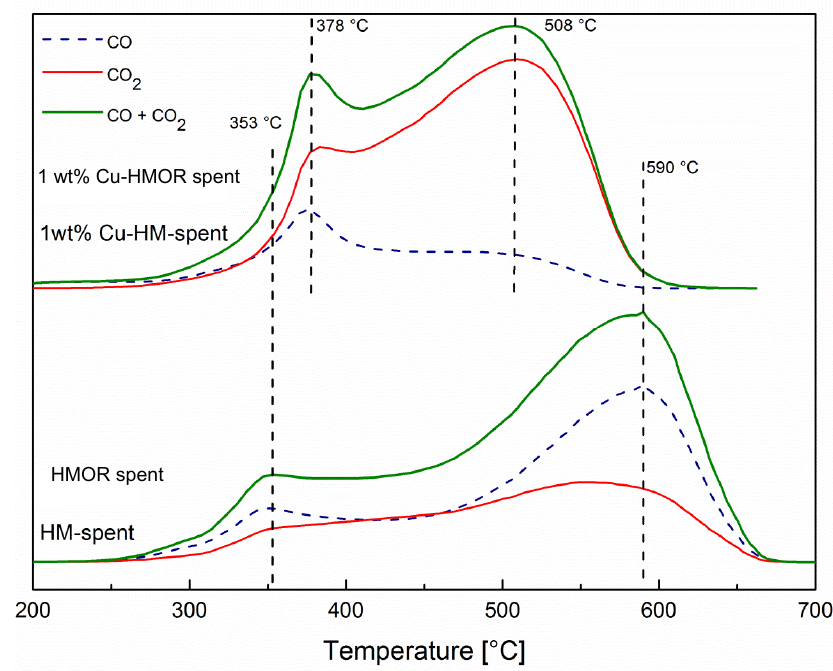
Figure 5. TPO of spent HMOR and 1 wt% Cu-MOR catalysts. The nature of the copper-species in the 1 wt% Cu-MOR catalyst was examined before and after the reaction by XPS (Figure S6) and EPR spectroscopy (Figure S7). The charac- teristic binding energies of Cu at 933.5 and 953.2 eV in XPS resulted from the spin-orbit doublet of the Cu 2p core level transitions. Deconvolution of the Cu transition 2p 3/2 signal resulted in two main contributions located around 933.5 and 935 eV, respectively, which tentatively was assigned to CuO [51] (or to Cu 2+ introduced by cation exchange [52]) and to Cu 2+ -species with a different coordination or environment [53]. The characteristic satellite features of the Cu 2p transitions can further distinguish oxidation states in the catalysts. In the fresh Cu-MOR catalyst, a satellite doublet peak between 940 and 945 eV confirmed the presence of Cu 2+ species whereas a weak satellite between 945 and 950 eV suggested the presence of Cu + -species in the spent catalyst after the reaction [54]. The intensity of the signal at 935 eV, corresponding to Cu 2+ with different coordination, was reduced markedly in the spent catalyst in comparison to the fresh catalyst, while the intensity of the peak at 933.5 eV, assigned to CuO, remained intact. This suggest that the CuO nanoparticles remained unchanged throughout the reaction, but Cu 2+ with a different environment transformed to Cu + or Cu 0 in the spent catalyst during CO activation and/or